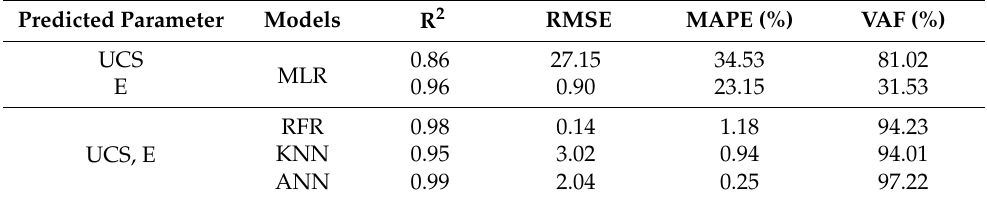
Table 6. Performance indices of the developed models. Predicted